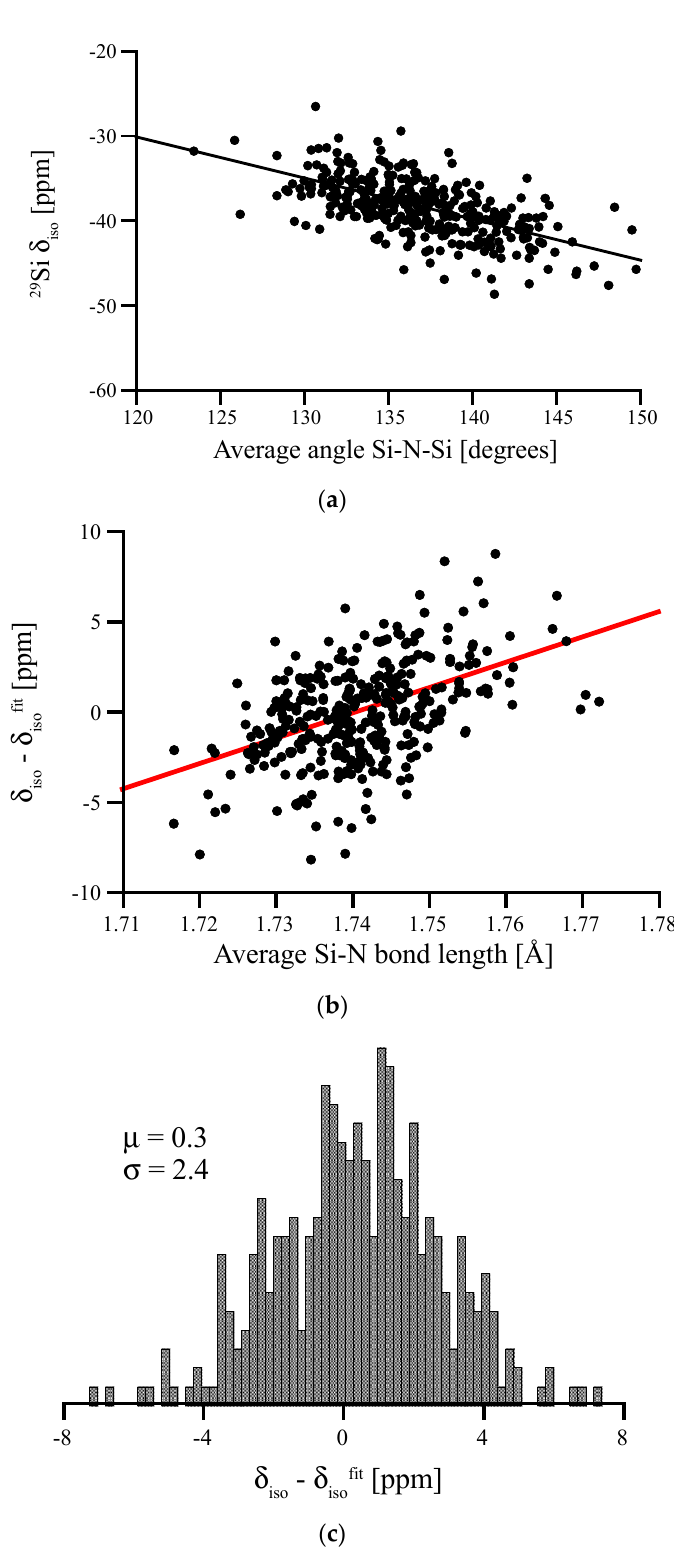
Figure 11. ( a ) Angular correlation between average Si-N-Si angle surrounding a Si [4] site in amorphous Si(NH) 2 and its 29 Si chemical shift. ( b ) Residual (deviations of data points from linear fit) plotted vs. the average Si-N bond length. ( c ) Residual of the two-variable fit (bond angle and bond length; equation see text) along with the mean deviation from fit ( µ ) and standard deviation ( σ ).